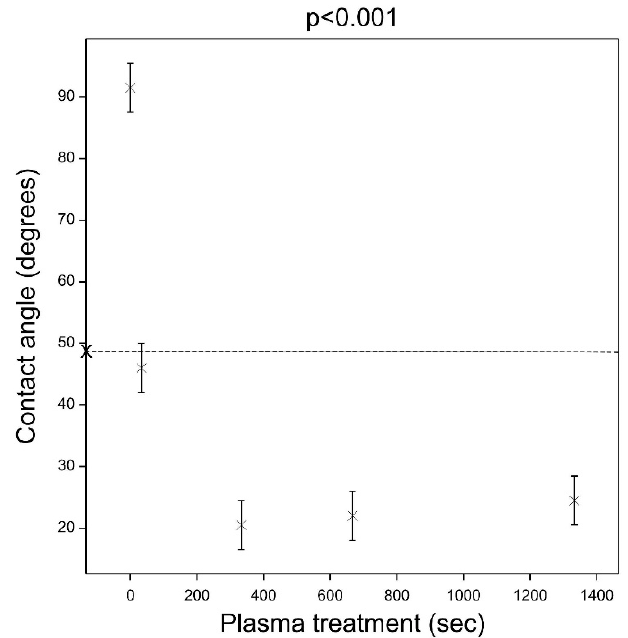
Figure 1. Effect of plasma treatment on the contact angle of water droplets on the surface of hot-oil modified blue-stained lodgepole pine wood. The bold X symbol on the y-axis and the horizontal dotted line indicate the contact angle of a water droplet on unmodified blue-stained lodgepole pine wood.